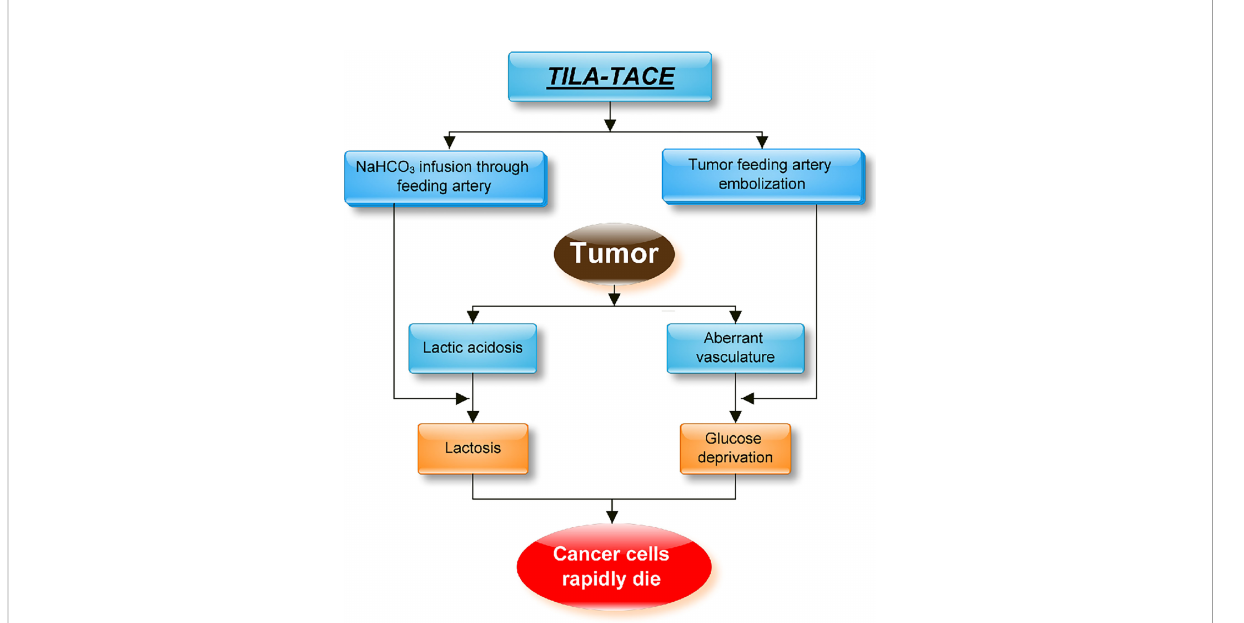
FIGURE 7 The hypothetical approach of TILA-TACE to treating large liver metastatic solitary fi brous tumors by targeting intratumoral lactic acidosis. cTACE embolizes tumor-feeding arteries that block glucose supply but also create a hypoxia condition and trap lactic acidosis. Intratumoral lactic acidosis rescues cancer cells from glucose deprivation. Hypoxia-enhanced angiogenesis could also signi fi cantly contribute to tumor survival. On the contrary, TILA-TACE is designed for neutralizing lactic acidosis by bicarbonate, which rapidly kills cancer cells before revascularization and thus signi fi cantly improves the therapeutic ef fi